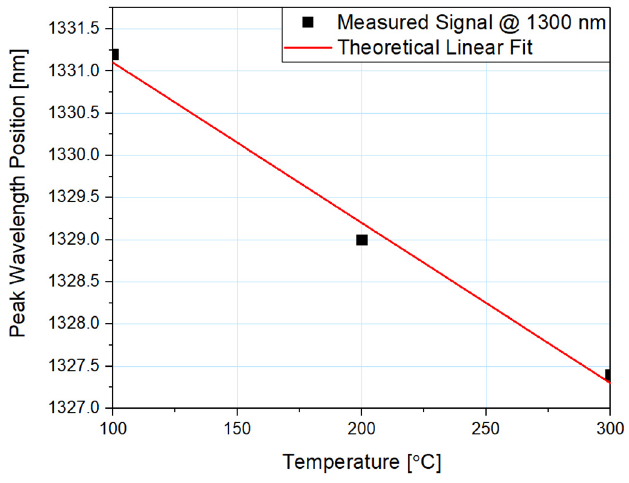
Figure 5. Dependence of the spectral shift of a reflected signal on the temperature.